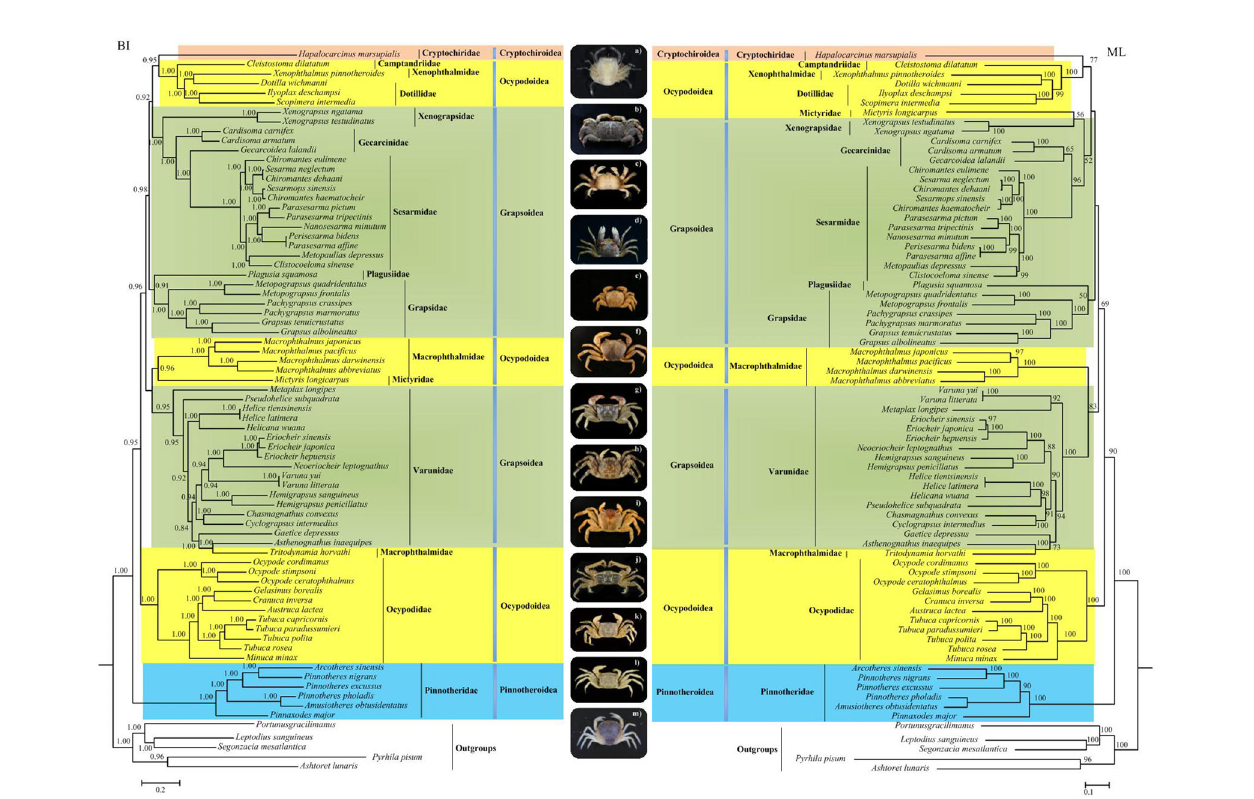
FIGURE 5 | The phylogenetic tree of Thoracotremata derived from Bayesian inference (BI) and Maximum Likelihood (ML) analyses using 13 PCGs. The number at each node is Bayesian posterior probability (BPP) for BI and bootstrap values (BP) for ML. Ocypodoidea, Grapsoidea, Cryptochiroidea, and Pinnotheroidea were also indicated by yellow, green, red, and blue background. Photographs on the medial position show the extent of morphological diversity of the Thoracotremata. Photographs: (A) Hapalocarcinus marsupialis Stimpson, 1858 sensu lato (Cryptochiridae), (B) Cleistostoma dilatatum De Haan, 1833 (Camptandriidae), (C) Xenophthalmus pinnotheroides White, 1846 (Xenophthalmidae), (D) Dotilla wichmannide Man, 1892 (Dotillidae), (E) Xenograpsus testudinatus N.K. Ng, J.-F. Huang & P.-H. Ho, 2000 (Xenograpsidae), (F) Cardisoma carnifex (Herbst, 1796) (Gecarcinidae), (G) Parasesarma af fi ne (De Haan, 1837) (Sesarmidae), (H) Plagusia squamosa (Herbst, 1790) (Plagusiidae), (I) Grapsus albolineatus Latreille in Milbert, 1812 (Grapsidae), (J) Macrophthalmus (Macrophthalmus) abbreviatus R.B. Manning & Holthuis, 1981 (Macrophthalmidae), (K) Helicana wuana (Rathbun, 1931) (Varunidae), (L) Ocypode stimpsoni Ortmann, 1897 (Ocypodidae), and (M) Pinnotheres pholadis De Haan 1835